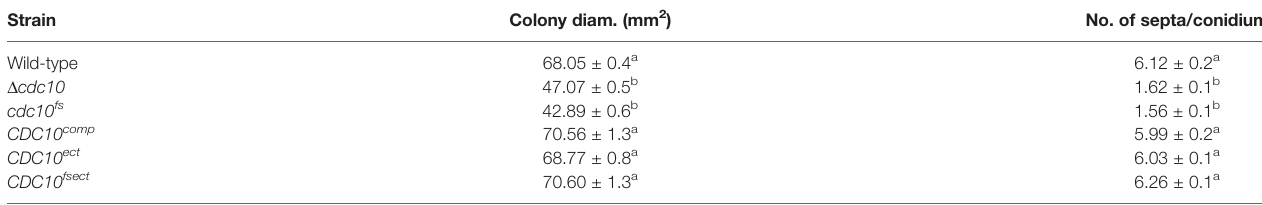
TABLE 1 | Vegetative growth and septation of CDC10